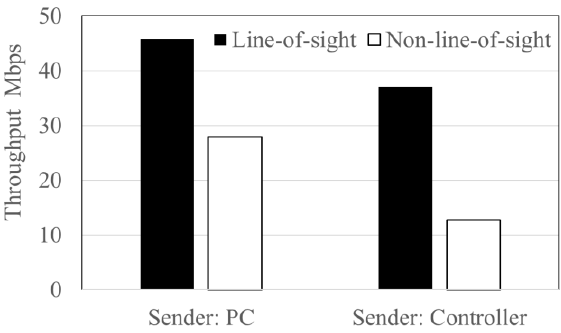
Figure 17. Average TCP throughput results considering position for excavator’s bucket (the distance between the PC and the controller is 10 m). The black bar is the results of line-of-sight communication, and the white bar is results of non-line-of-sight communication, respectively.